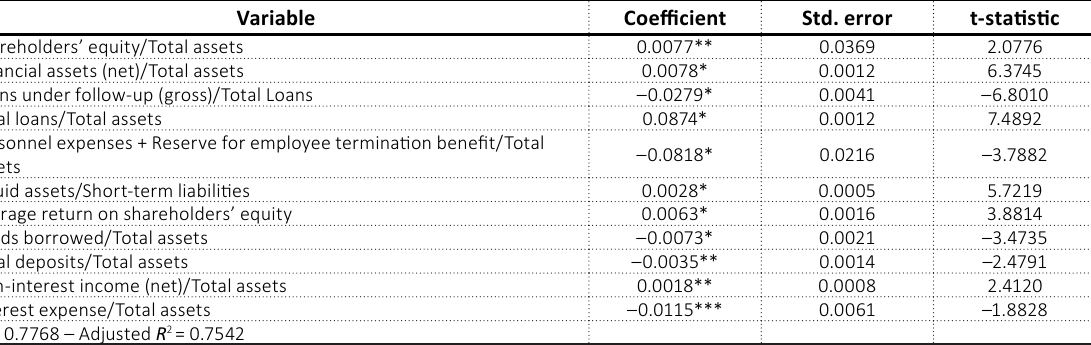
Table 6. Stepwise regression analysis